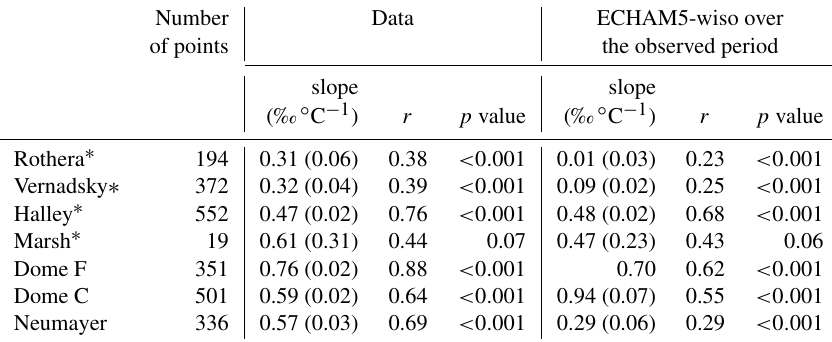
Table 5. Slope (in ‰ ◦ C − 1 ), correlation coefficient, and p value of the δ 18 O–temperature linear relationship from precipitation measure- ments over the available period at daily or monthly (when the name of the station is associated with an asterisk) scale, depending on the time resolution of the data, and from the ECHAM5-wiso model over the observed period at the time resolution of the data. Numbers in brackets correspond to the standard errors. Number Data ECHAM5-wiso